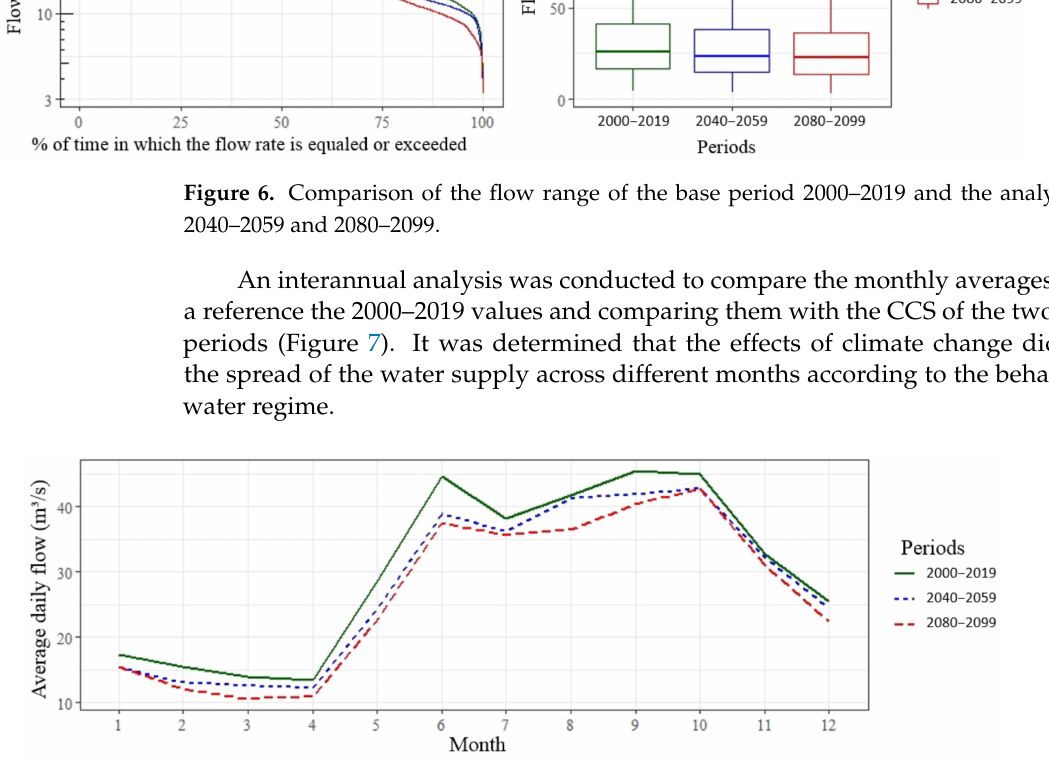
Figure 7. The water regime of the basin for the base period and those affected by the